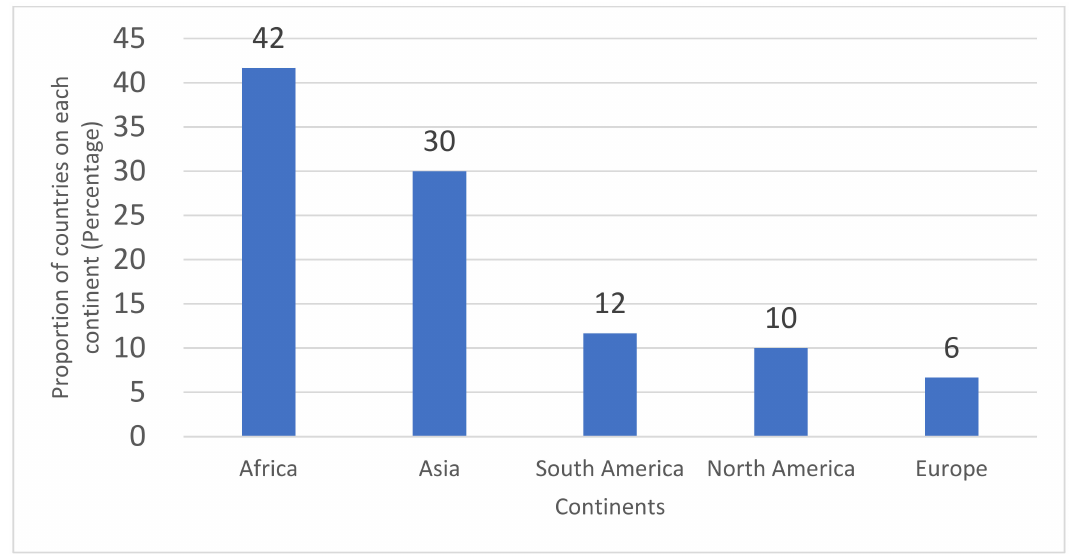
Figure 1. Continental distribution of the 60 sampled